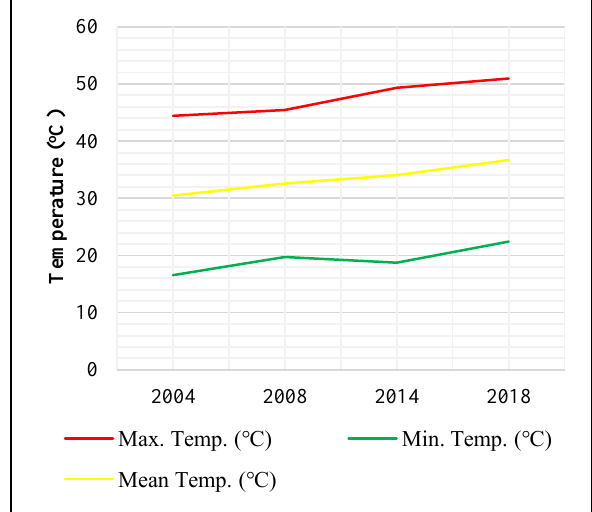
Figure 3. Summary of the LST trend between 2004 and 2018 The minimum to maximum ranges of the annual mean surface temperature in Abuja are 27.87°C, 25.56°C, 30.59°C, 28.53°C for 2004, 2008, 2014 and 2018 respectively (Figure 3). Results also show a gradual increase in mean surface temperature by at